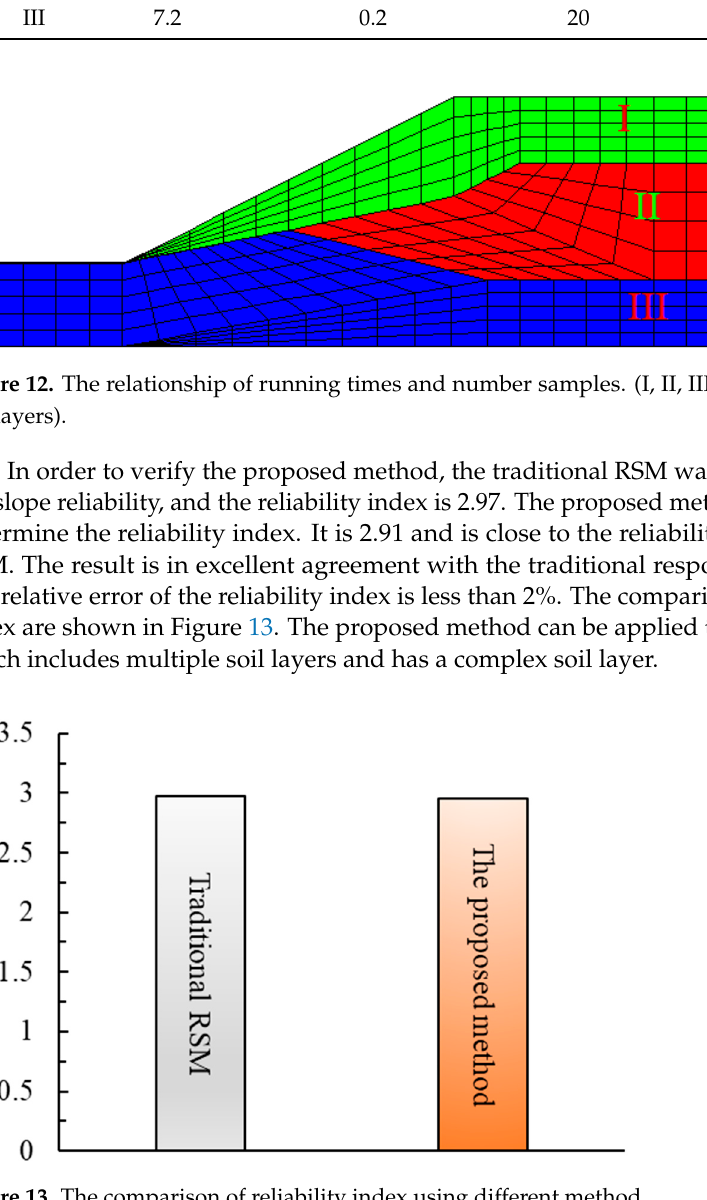
Figure 13. The comparison of reliability index using different method.